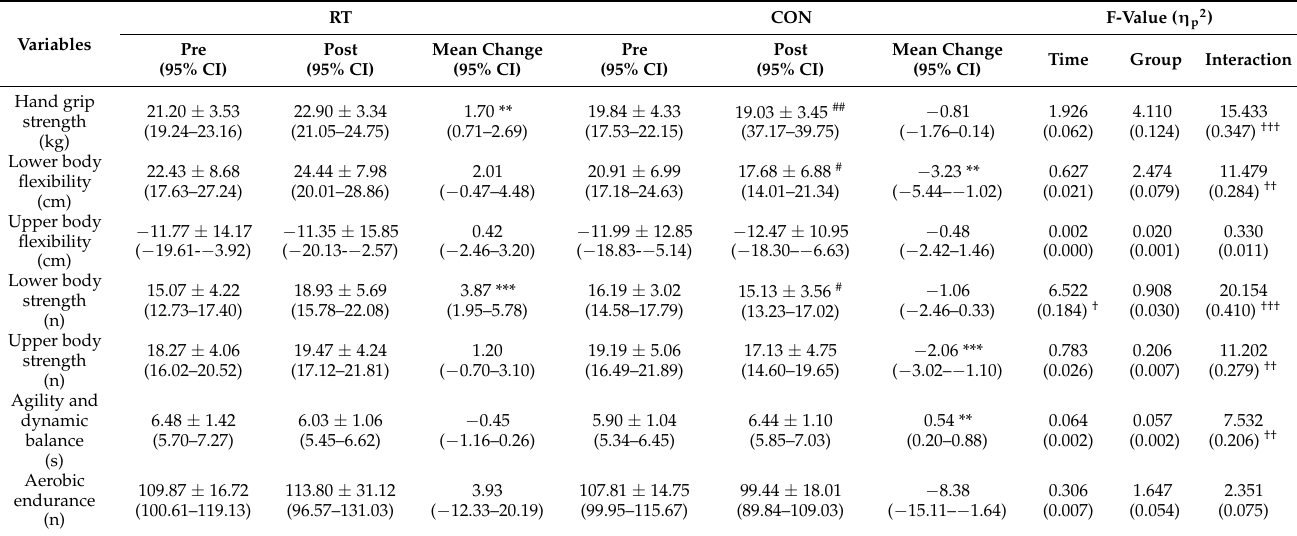
Table 4. Changes of functional fitness between pre- and post-tests in obese older women.